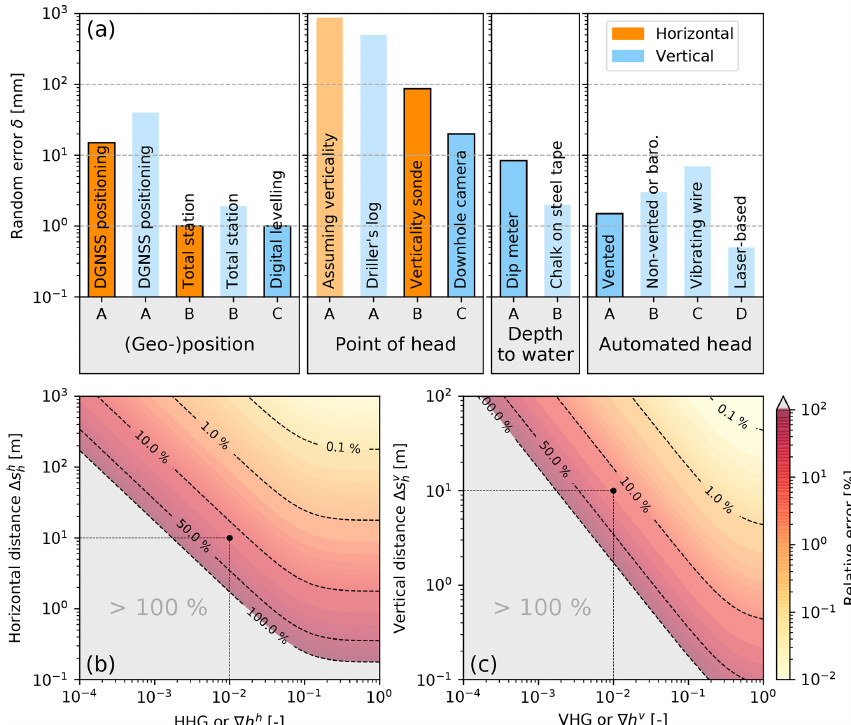
Figure 12. (a) Visual comparison of horizontal and vertical random errors based on precision values in Table 1 (note that some errors are distance dependent) for the different steps (Fig. 1) and method options. Minimum achievable relative random head gradient error in the horizontal (b) and vertical (c) direction calculated using standard-practice measurements (highlighted by the black frame: step 1, options A, B and C; step 2, options B and C; step 3, option A; step 4, option A). Note that HHG and VHG values with errors exceeding 100% are blanked out in (b) and (c) . Please note the example error calculation in the main